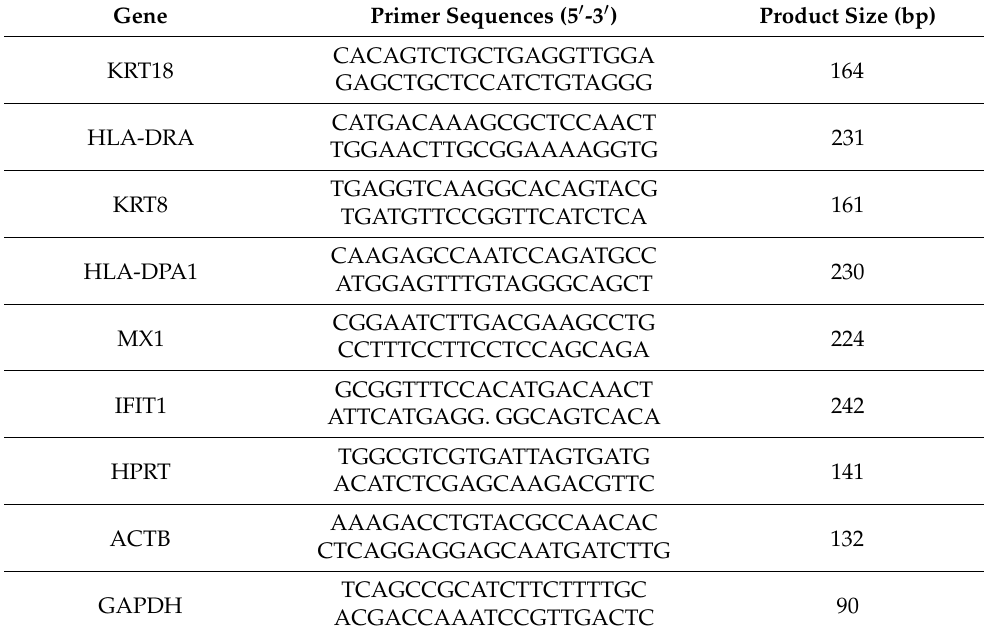
Table 1. Oligonucleotide. Sequences of primers used for RT-qPCR.